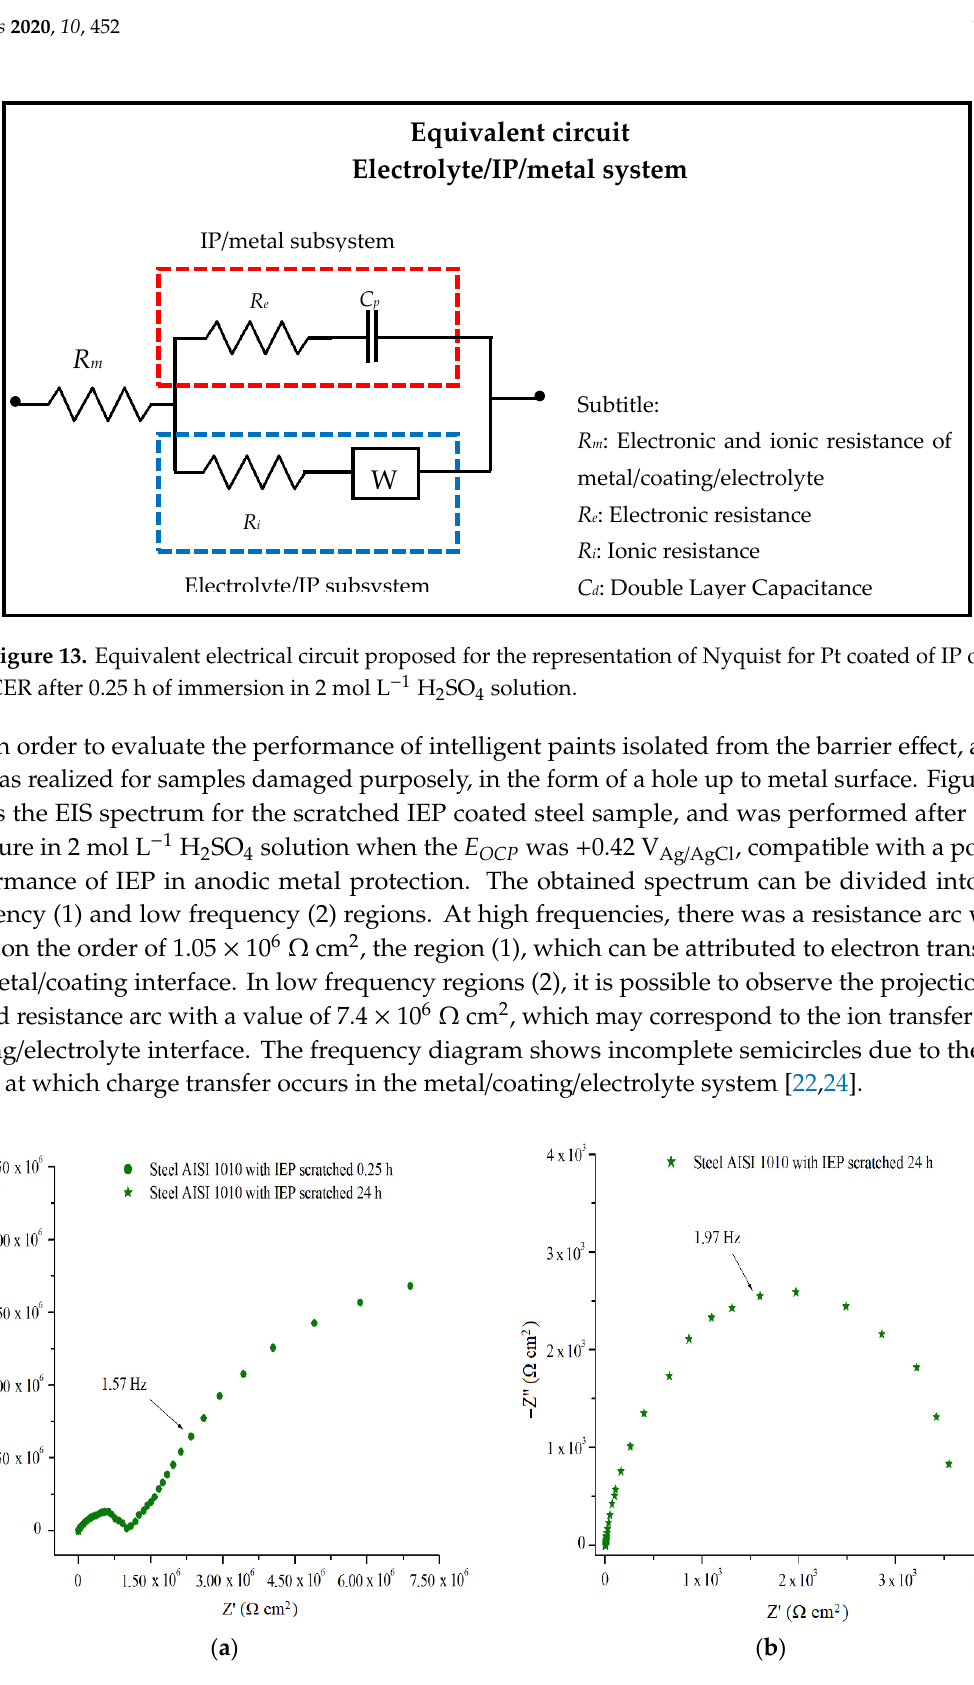
( b ) Figure 12. EIS in representation of Nyquist for coated Pt with IP of CER after ( a ) 0.25 h and 24 h; ( b ) 0.25 h of immersion in 2 mol L −1 H 2 SO 4 solution. Figure 12a shows the EIS assays of the coated Pt with IP de CER, after 24 h immersion in 2 mol L −1 H 2 SO 4 solution, an E OCP of +0.29 V Ag/AgCl was shown, similar to uncoated Pt or uncoated of PAni EB. The sample presented spectrum with resistance arcs of 6.00 × 10 8 Ω cm 2 . This obtained spectrum has two orders of magnitude larger than the resin without PAni, for the same time of exposure to the medium, which can be attributed to the formation of a layer of thicker or more organized Pt oxides, induced by the presence of the PAni EB binder contained in the IP. The proposed equivalent electrical circuit for representing Nyquist for IP of CER coated Pt, after 0.25 h exposure in 2 mol L −1 H 2 SO 4 solution, shown in Figure 13, indicates an electrolyte/coating/metal system that is subjected to an R m of H 2 SO 4 2 mol L −1 solution, and that there are two simultaneous subsystems in which one Ri represents the charge transfer and/or anions of the